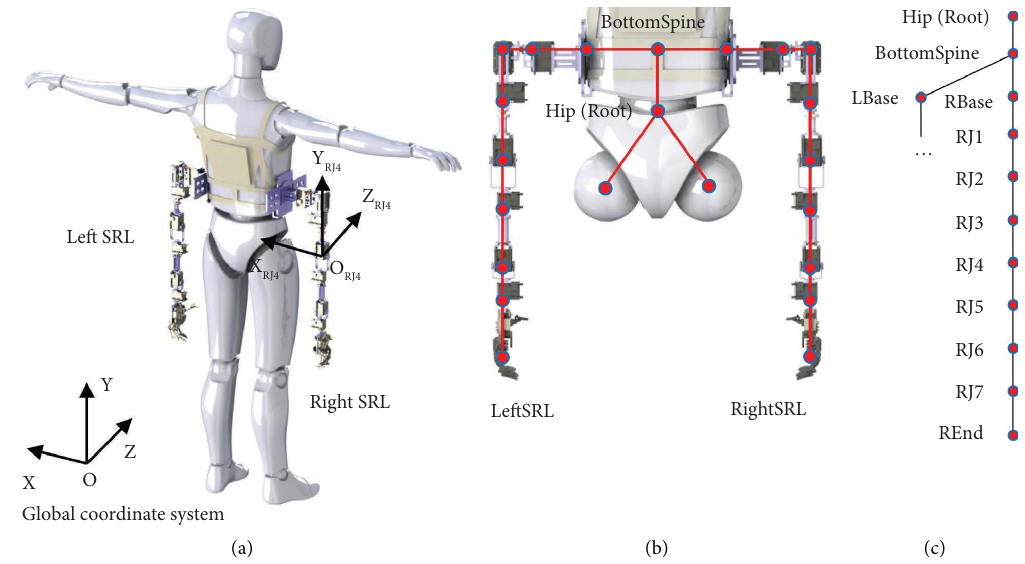
Figure 6: Te human-SRL system 3D model, the SRL skeleton, and the node tree of the SRL skeleton